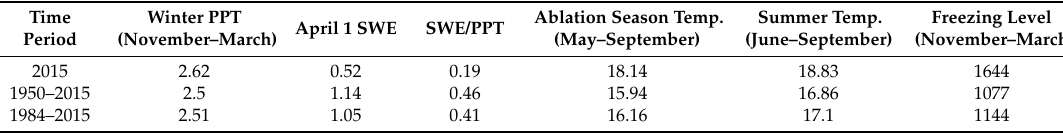
Table 5. Comparison of 2015 climate conditions to average conditions PPT = precipitation SWE = snow water